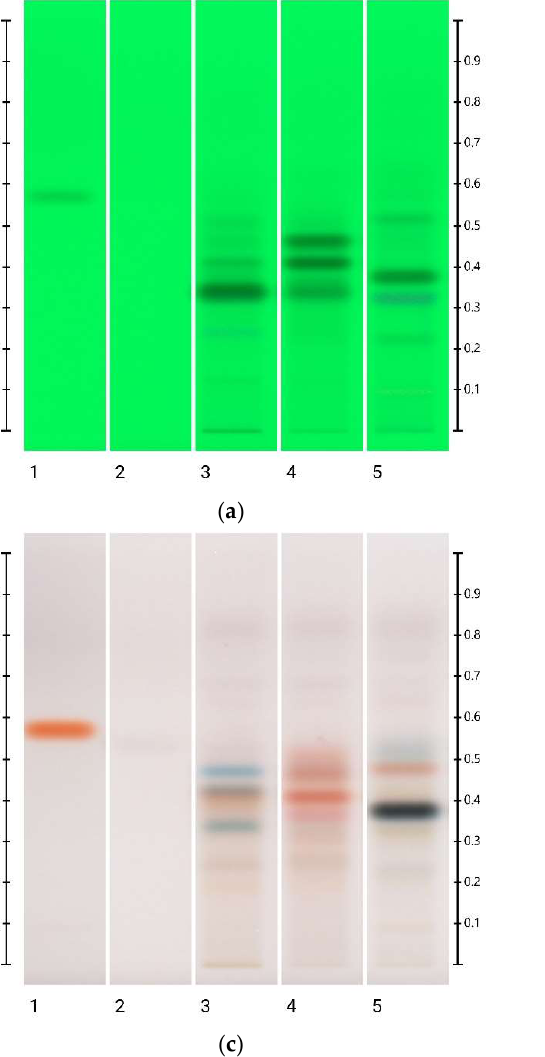
Figure 1. Images taken at ( a ) 254 nm; ( b ) 366 nm; ( c ) white light after derivatisation and ( d ) 366 nm after derivatisation with vanillin reagent; Track 1—4,5,7-trihydroxyflavanon, Track 2—ART, Track 3—LEP, Track 4—MAR, and Track 5—PEP; 5 μL of each honey extract, respectively, all at baseline (0 min).